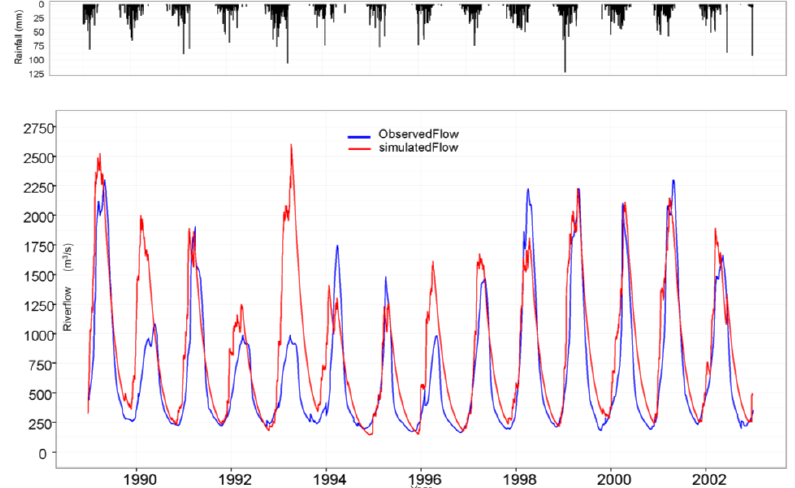
Figure 8. Calibration of Hydrological Model. HBV Calibration Results—Zambezi Basin at Victoria Falls gauging station. The HBV hydrological model was set up with several (5) sub basins. The discharge observations were only available at Victoria Falls (Pump station).